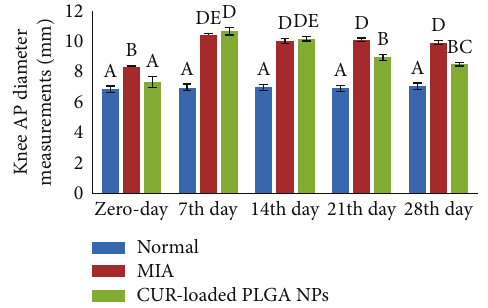
Figure 5: Knee anterior-posterior diameter measurements in the normal control, monosodium iodoacetate (MIA), and MIA+CUR- loaded PLGA NP groups. At each period, the means, which have di ff erent symbols (letters), are signi fi cantly di ff erent at P < 0 : 05